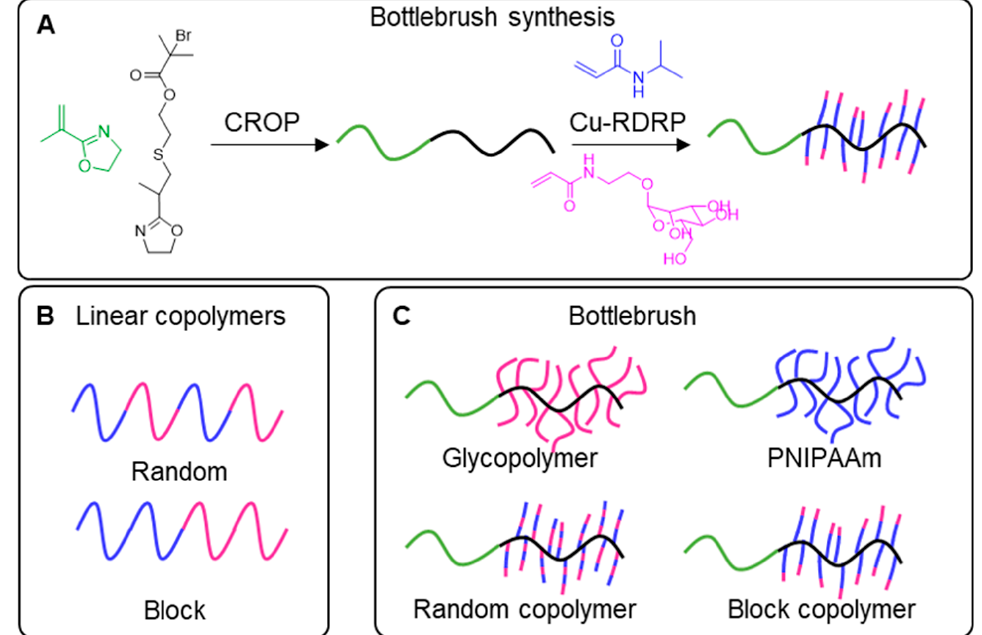
Figure 8. Schematic representation of the synthesis of oxazoline-based and mannose-containing linear and bottlebrushes copolymers. ( A ): Synthesis of copolymer bottlebrushes by combination of CROP with RDRP techniques; ( B ): representation of random and block linear copolymers; ( C ): representation of the di ff erent bottlebrushes with side chains of vary compositions, namely homopolymers (glycopolymer and PNIPAAm), random and block copolymers [89]. Table 1. Association constants ( K a ) between MBL and DC-SIGN lectins and PNIPAAm- and PManAA-based (co)polymers with different architecture and composition.